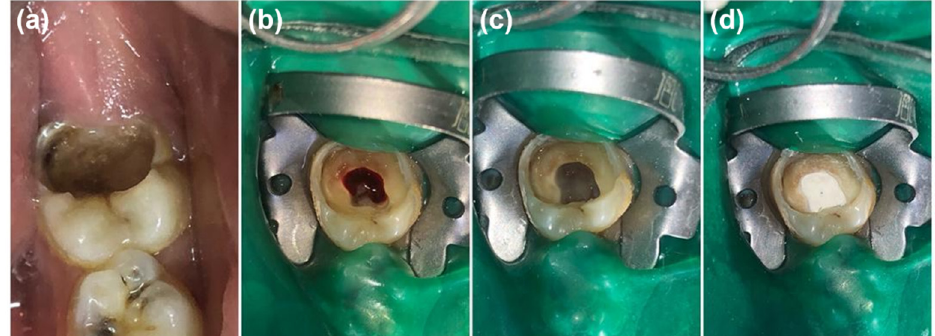
Figure 2. ( a ) Tooth isolated with rubber dam; ( b ) caries and coronal pulp removal; ( c ) pulp stumps after achieving hemostasis; ( d ) the placement of the pulpotomy agent.